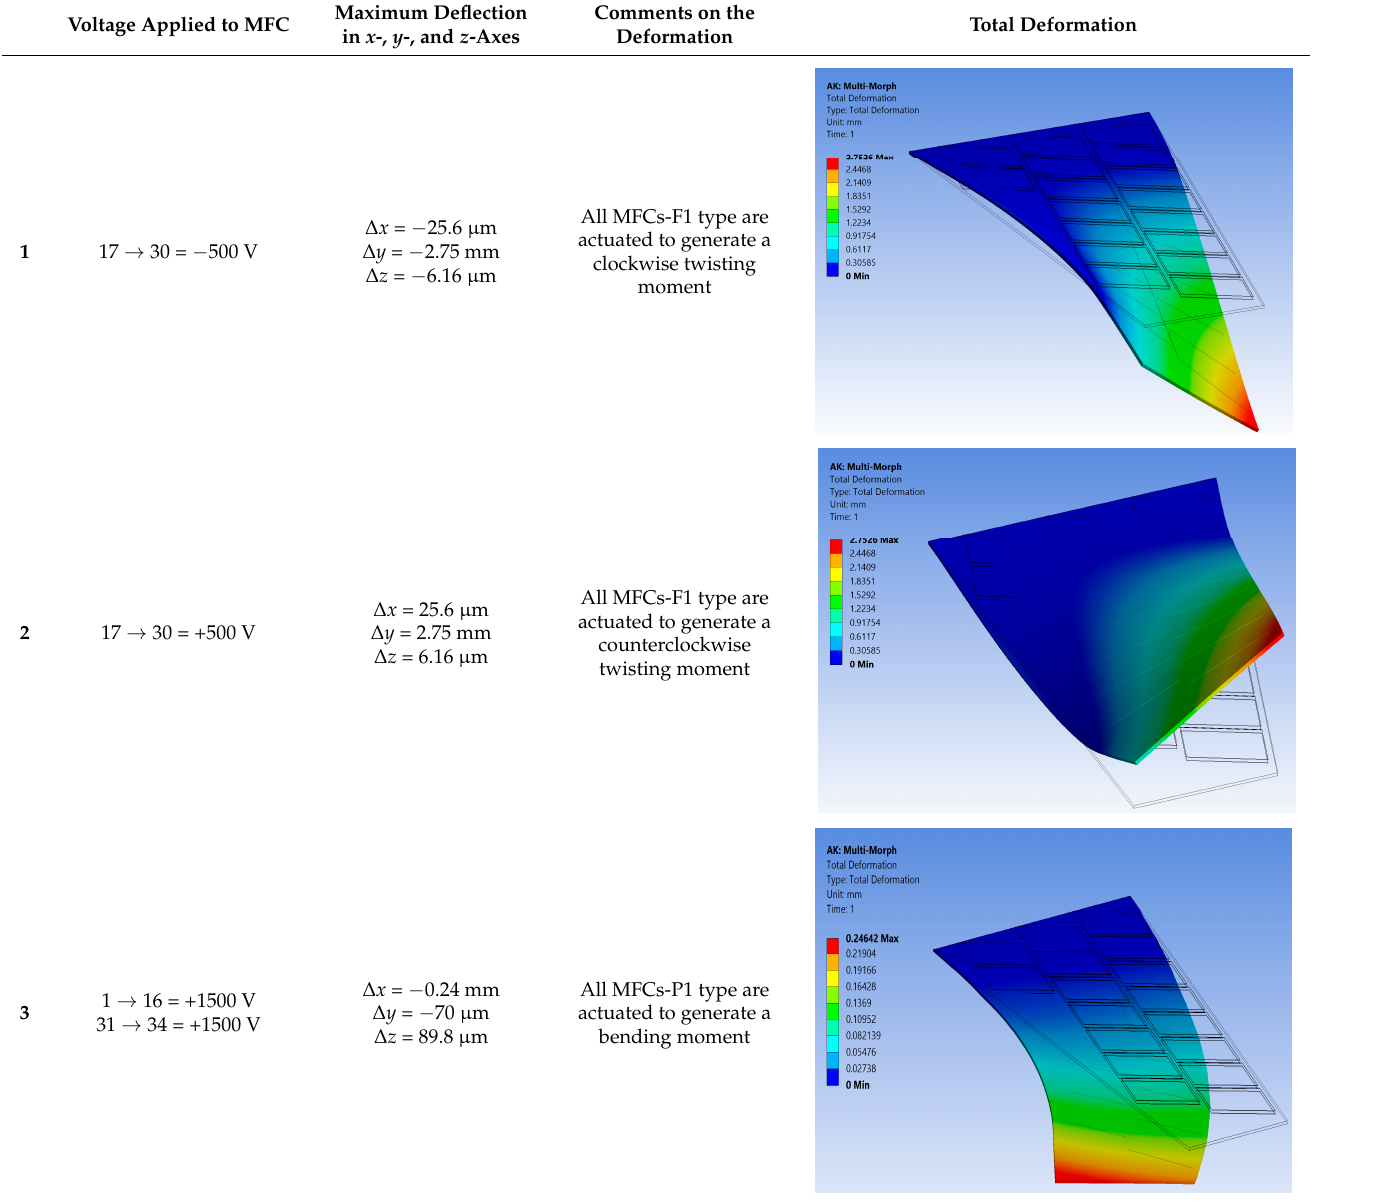
Table 5. Different configurations for morphing sweptback wing.